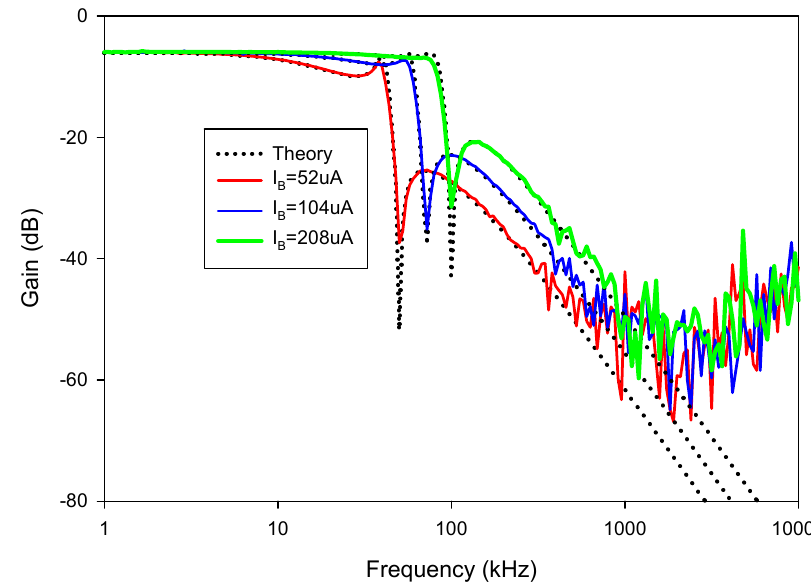
Figure 42. The experimental frequency responses of the LP ladder filter with different I B .